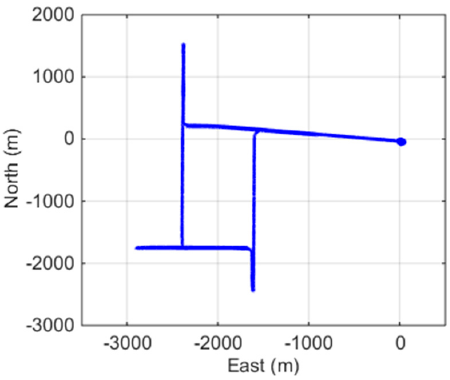
Figure 3. Trajectory of the land vehicle.